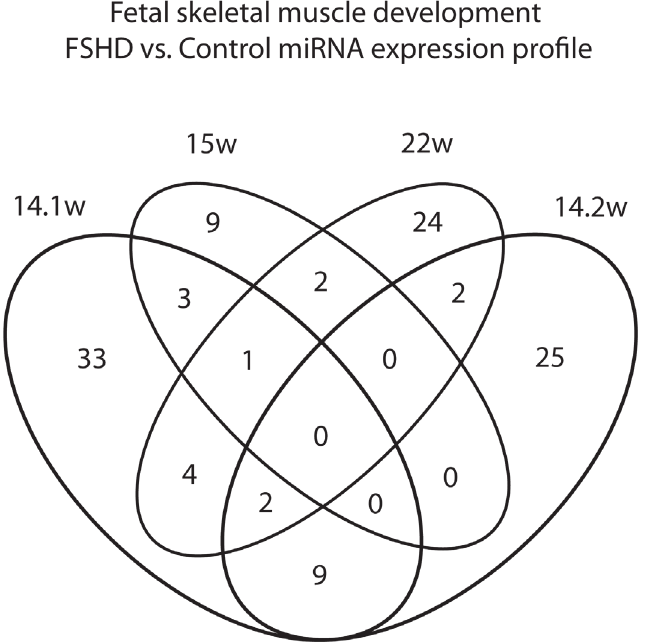
Figure 4. Venn-diagram showing the number of miRNAs modulated in FSHD1 fetuses at different stages of development. 52 miRNAs were differentially expressed in the FSHD1 fetus at 14 weeks of development carrying 4.5 D4Z4 repeat units (FSHD 14.1), while 38 microRNAs were modulated in the FSHD1 fetus at 14 weeks of development with 1.5 D4Z4 repeat units (FSHD 14.2). These two fetuses at the same stage share 11 modulated miRNAs. 15 miRNAs were modulated in the FSHD1 fetus at 15 weeks of development, while at 22 weeks of development, we observed 35 differentially expressed miRNAs in FSHD1.